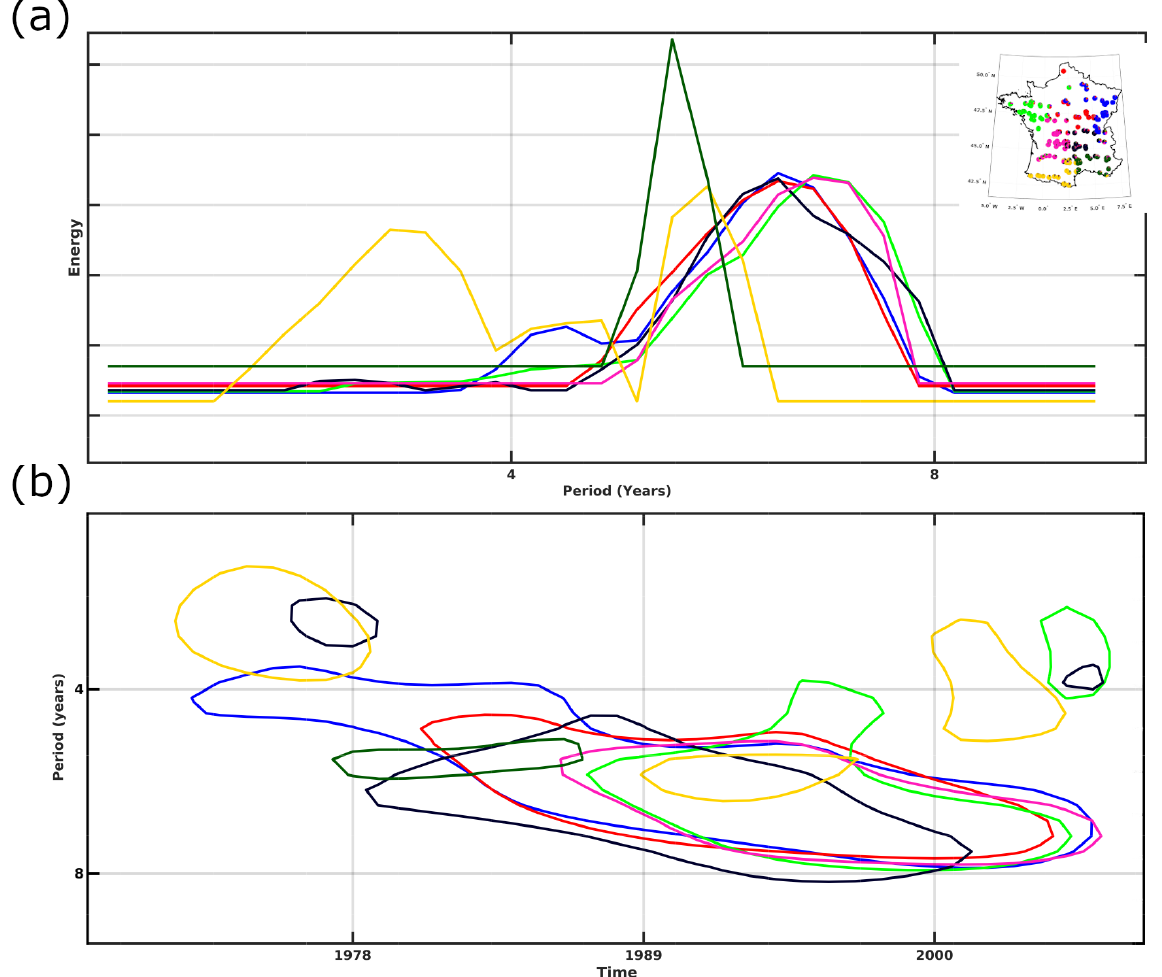
Figure 5. Interannual precipitation time frequency variability in France. (a) Global wavelet spectra of homogeneous regions. (b) Wavelet spectra of homogeneous regions. For clarity, only timescales and time locations that are 95% statistically significant and with the largest variability are shown (colored